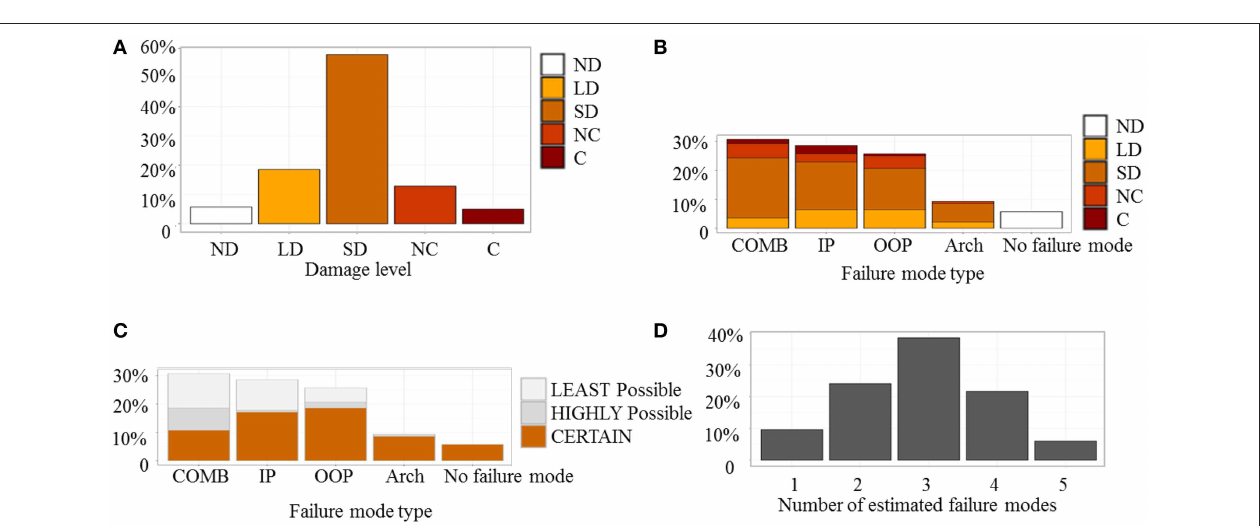
FIGURE 11 | Identification of the building blocks inspected in the historic center of L’Aquila. The red line delimits the border of the historic center. The red dots indicate the location of the inspected façades.